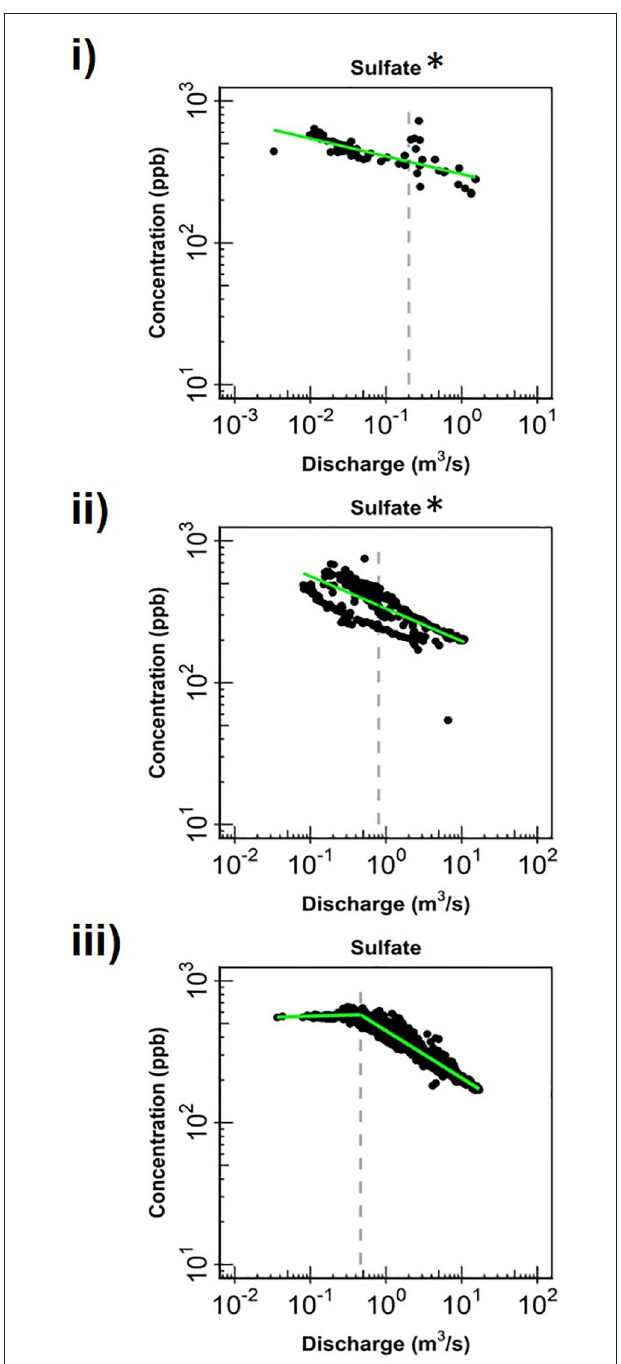
FIGURE 5 | Change in log-log relationships for SO 4 at (i) EAQ, (ii) EBC, and (iii) PH when segmenting the hydrograph at the median discharge (dashed gray line). Green lines represent segmented linear fits to the data, and * indicates if slopes at low and high flows are significantly similar to each other at 0.10 level.